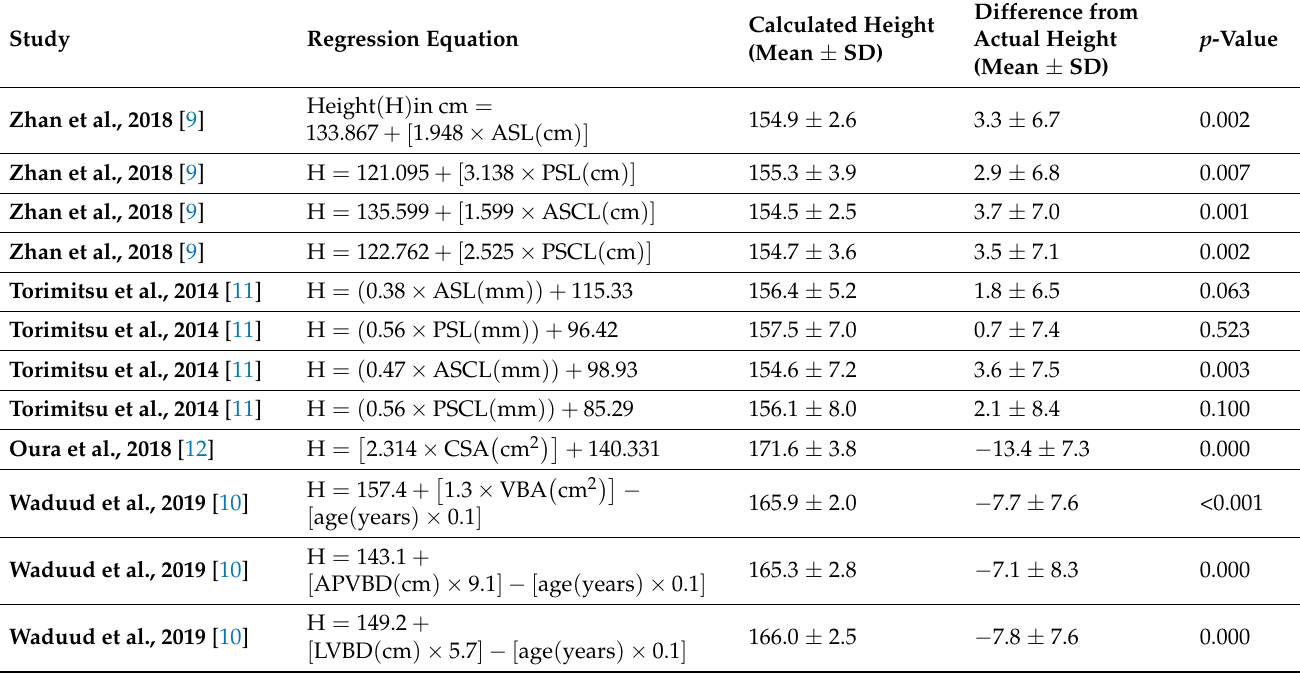
Table 5. Accuracy of regression formulae for height calculation in female participants.